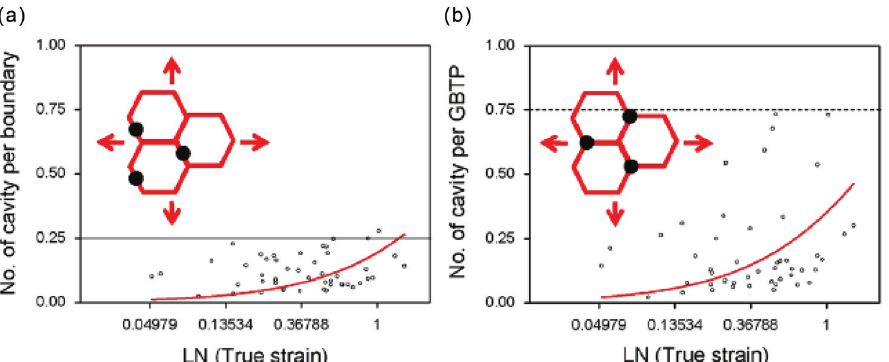
deformed austenite dendrites. After nucleation of the voids, the voids would align themselves and grow under the influence of favourable tensile stress and plas- tic strain. Eventually the voids would join up leading to final rupture in the tertiary region of the creep curve.